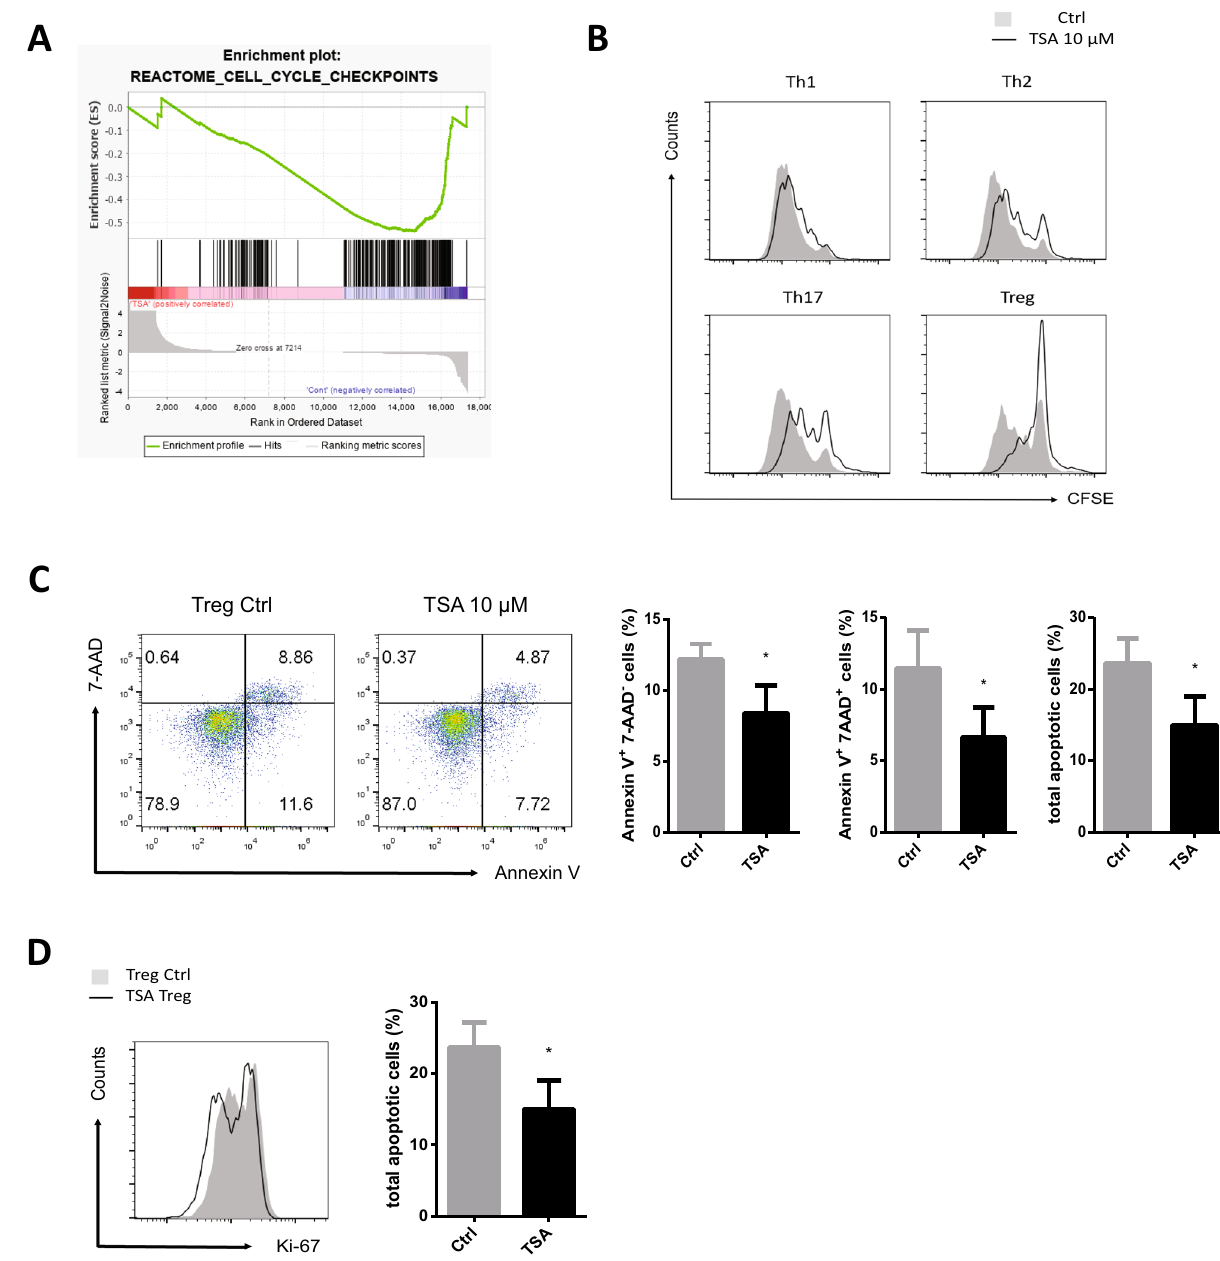
Figure 6. Reduced proliferation in the presence of the HDAC6 inhibitor is due to diminished proliferation rather than to increased apoptosis. ( A ) GSEA plot of genes related to cell cycle checkpoints. ( B ) Naïve CD4 + T cells were stained with CFSE and differentiated for 3 days into each CD4 + T cell subset in the presence of vehicle (control) or TSA (10 μM). The proliferation of each CD4 + T cell subset was quantified by measuring CFSE fluorescence. ( C ) Naïve CD4 + T cells were differentiated for 3 days into Treg cells in the presence of vehicle (control) or TSA (10 μM). Apoptosis of Treg cells was measured by flow cytometry after Annexin V/7-AAD staining. ( D ) Cells were cultured as described in C. Ki-67 protein expression was analyzed by flow cytometry. Data shown in the dot plot and histogram are representative of four independent experiments. Statistical analysis in C and D was performed using data pooled from four independent experiments. Error bars represent the SD, and P values were determined by the Student’s t test. * P < 0.05; ** P < 0.01; *** P < 0.001; and **** P < 0.0001, n.s., not